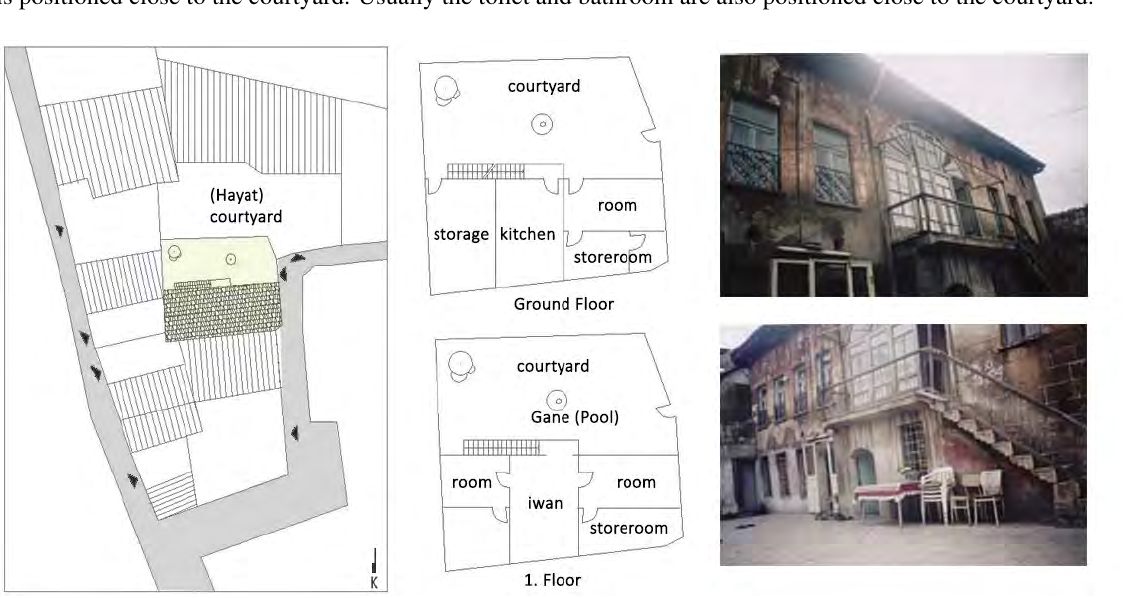
Figure 9. Spatial organization in traditional Gaziantephousing (Adopted from, Tas¸do˘gan, A. D.